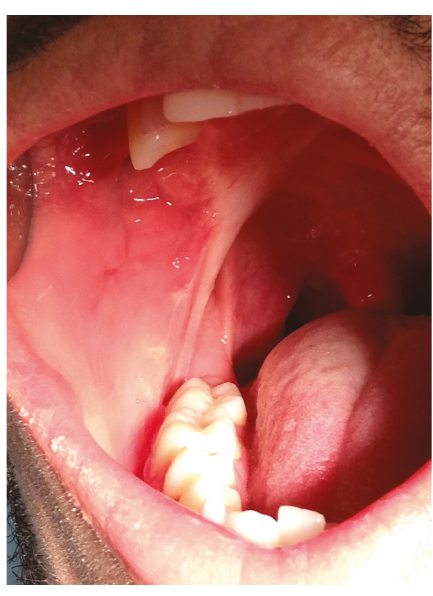
Figure 8: One-year